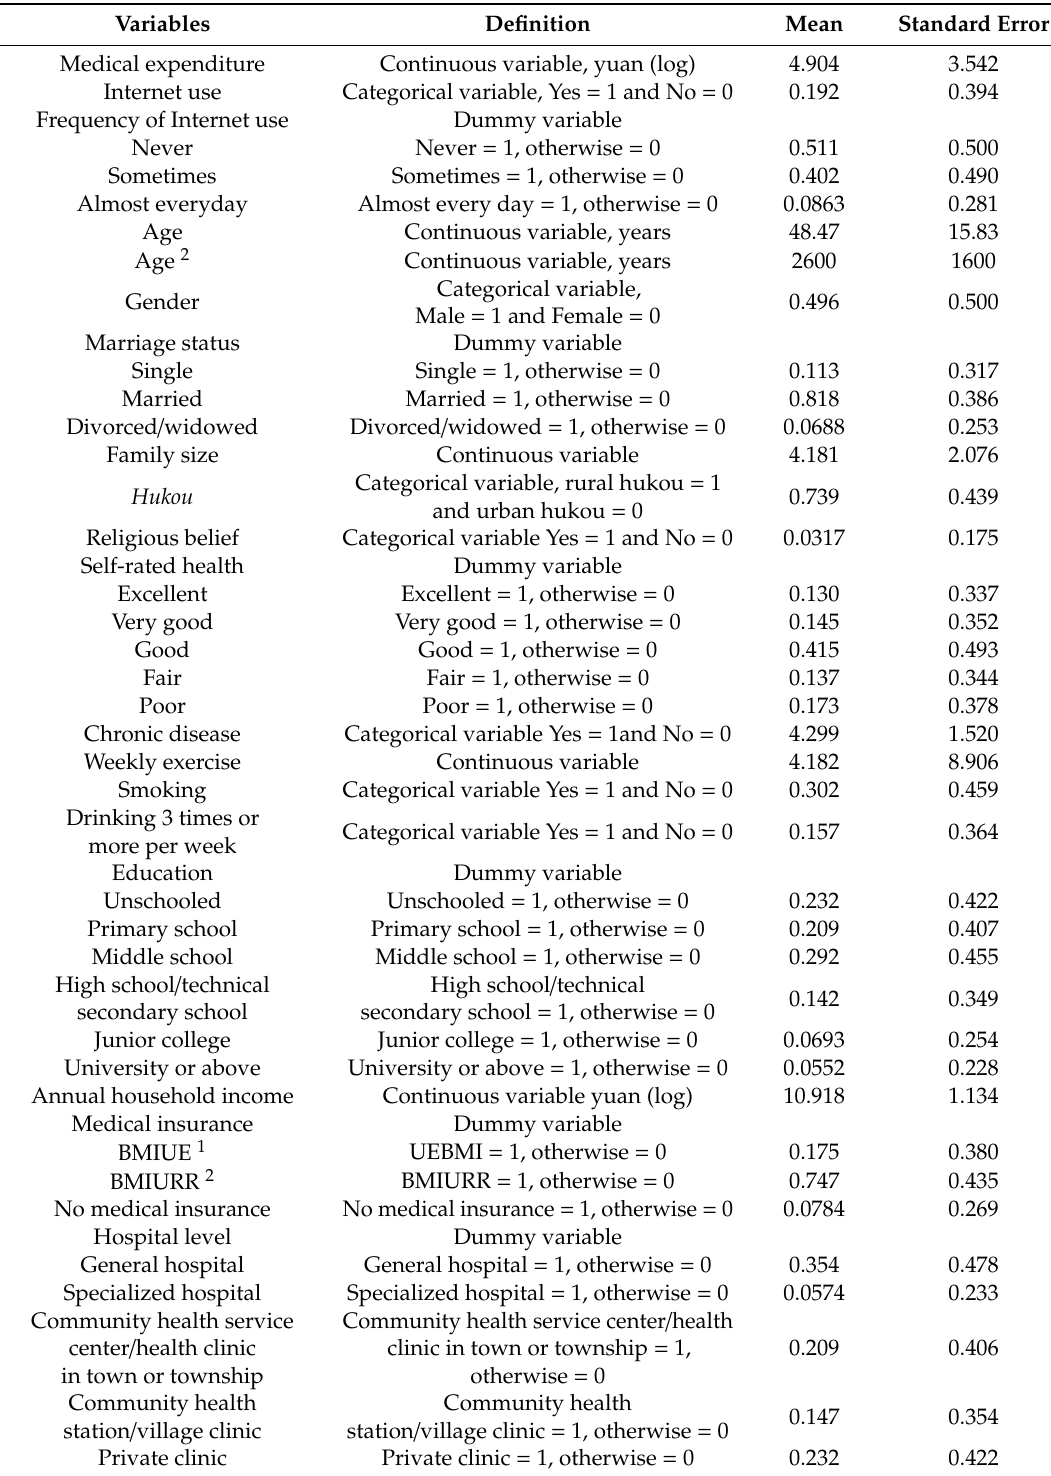
Table 1. Variable definitions and descriptive